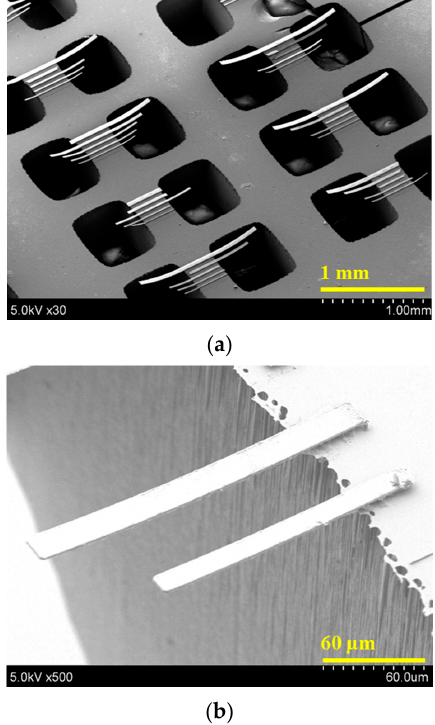
Figure 7. SEM images of fabricated Tb 0.34 Dy 0.65 Fe 1.9 bi-material cantilevers. ( a ) Low magnification of bi-material cantilevers; ( b ) High magnification of bi-material cantilevers.